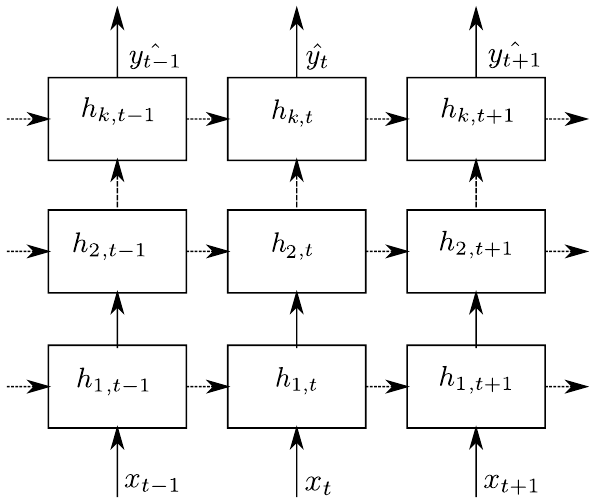
Figure 4. Stacked architecture—a hidden layer is multiplied and stacked on top of each other creating a grid of